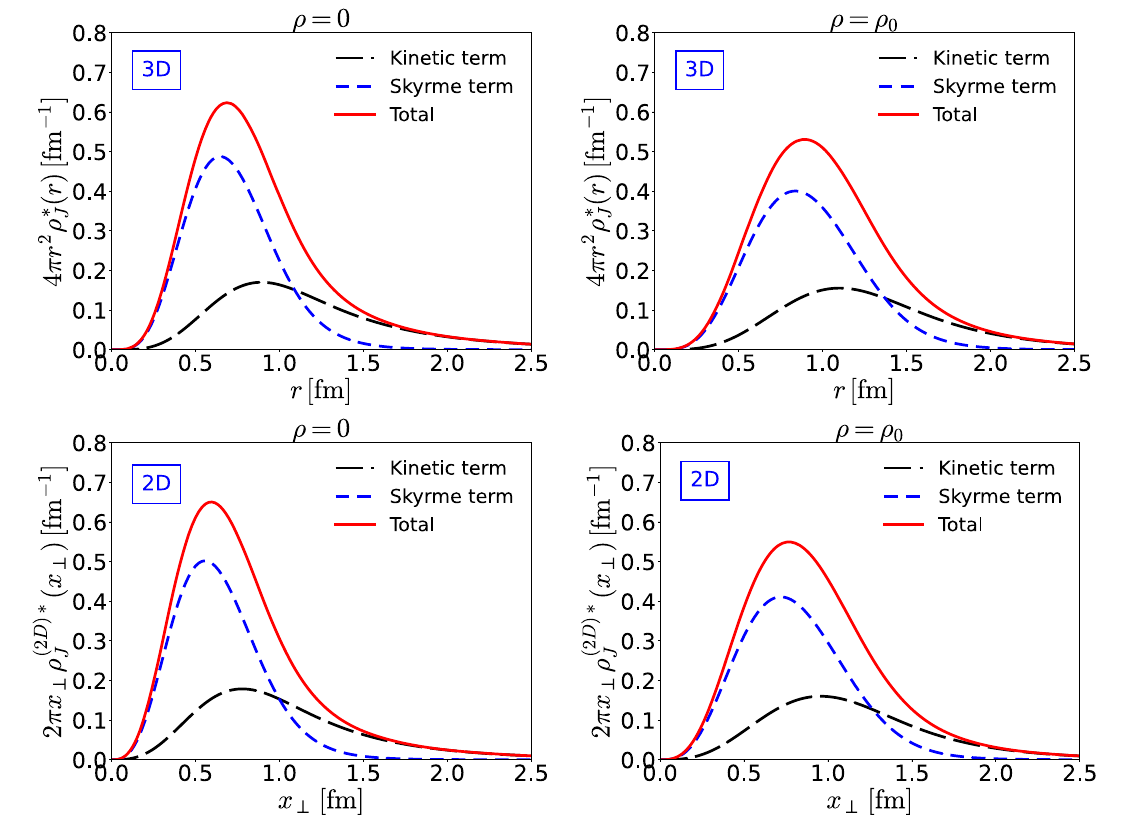
Fig. 3 The 3D angular momentum distributions of the nucleon. The upper-left(-right)paneldepictsthe3Dangularmomentumdistributions multiplied by 4 π r 2 at ρ = 0 ( ρ = ρ 0 ). The lower-left (-right) panel